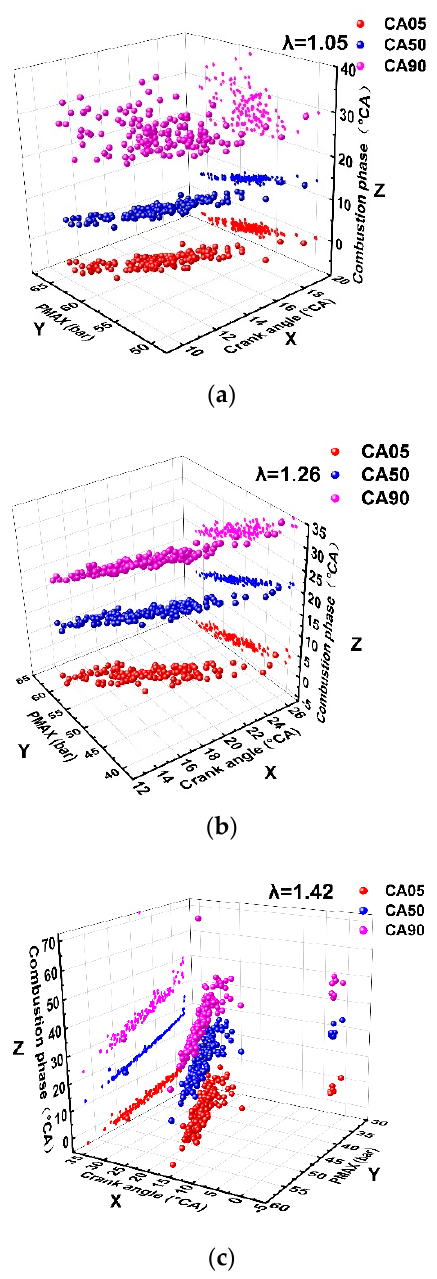
Figure 9. Combustion parameters and PMAX distribution under different λ : ( a ) Combustion phase parameters and PMAX distribution at λ = 1.05; ( b ) Combustion phase parameters and PMAX distribution at λ = 1.26; ( c ) Combustion phase parameters and PMAX distribution at λ = 1.42. In order to quantify the correlation between combustion phase parameters and PMAX distribution under different λ , plane fitting between CA05, CA50, CA90 and PMAX distribution is carried out. The fitting parameters are given in Tables 6–8, respectively. It can be seen from the table that under all the equivalent ratio conditions, both CA05 and CA50 show high correlation with PMAX distribution, while the correlation between CA90 and PMAX distribution is relatively unstable. Among all the parameters, the correlation between CA50 and PMAX distribution is the highest, and the correlation under all working